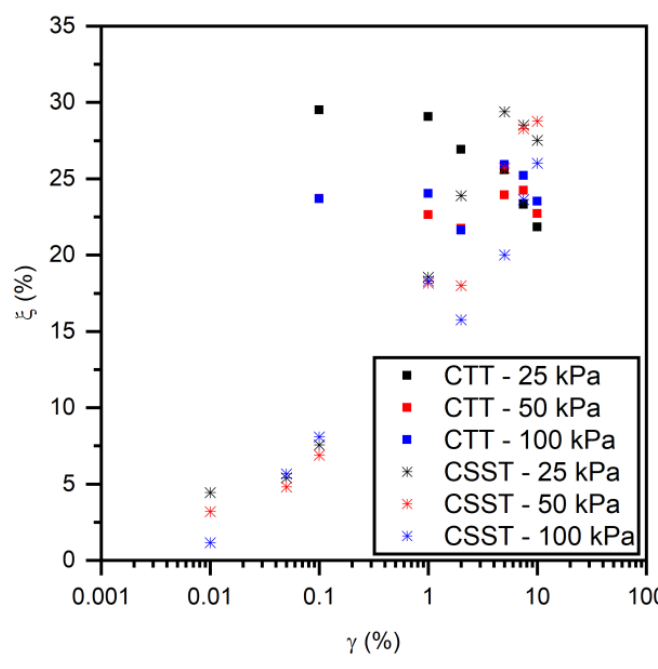
Figure 8. Comparison of damping ratios with shear strain amplitude from CTT and CSST.